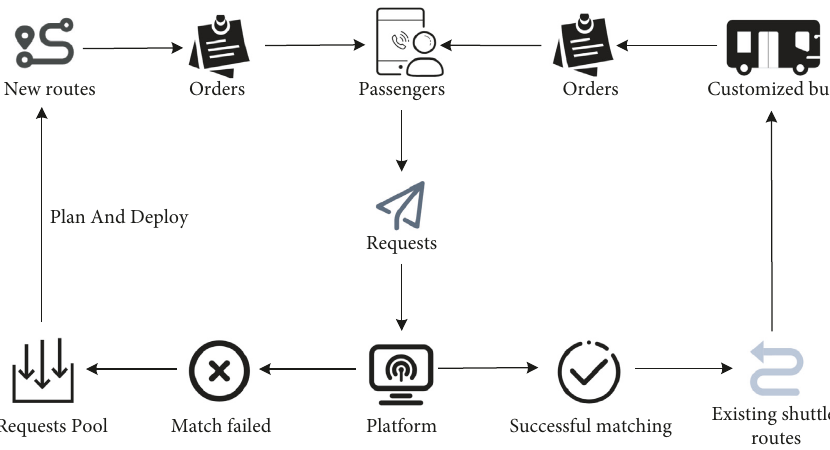
Figure 1: The entire process of the customized bus